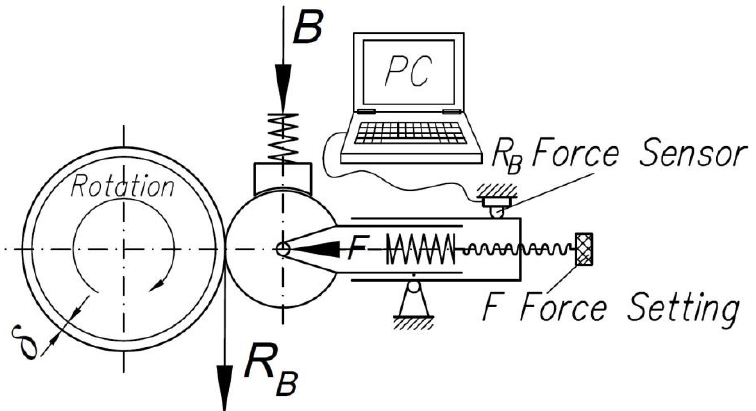
Figure 6. Schematic diagram of roller burnishing with braking torque applied directly to the roller.